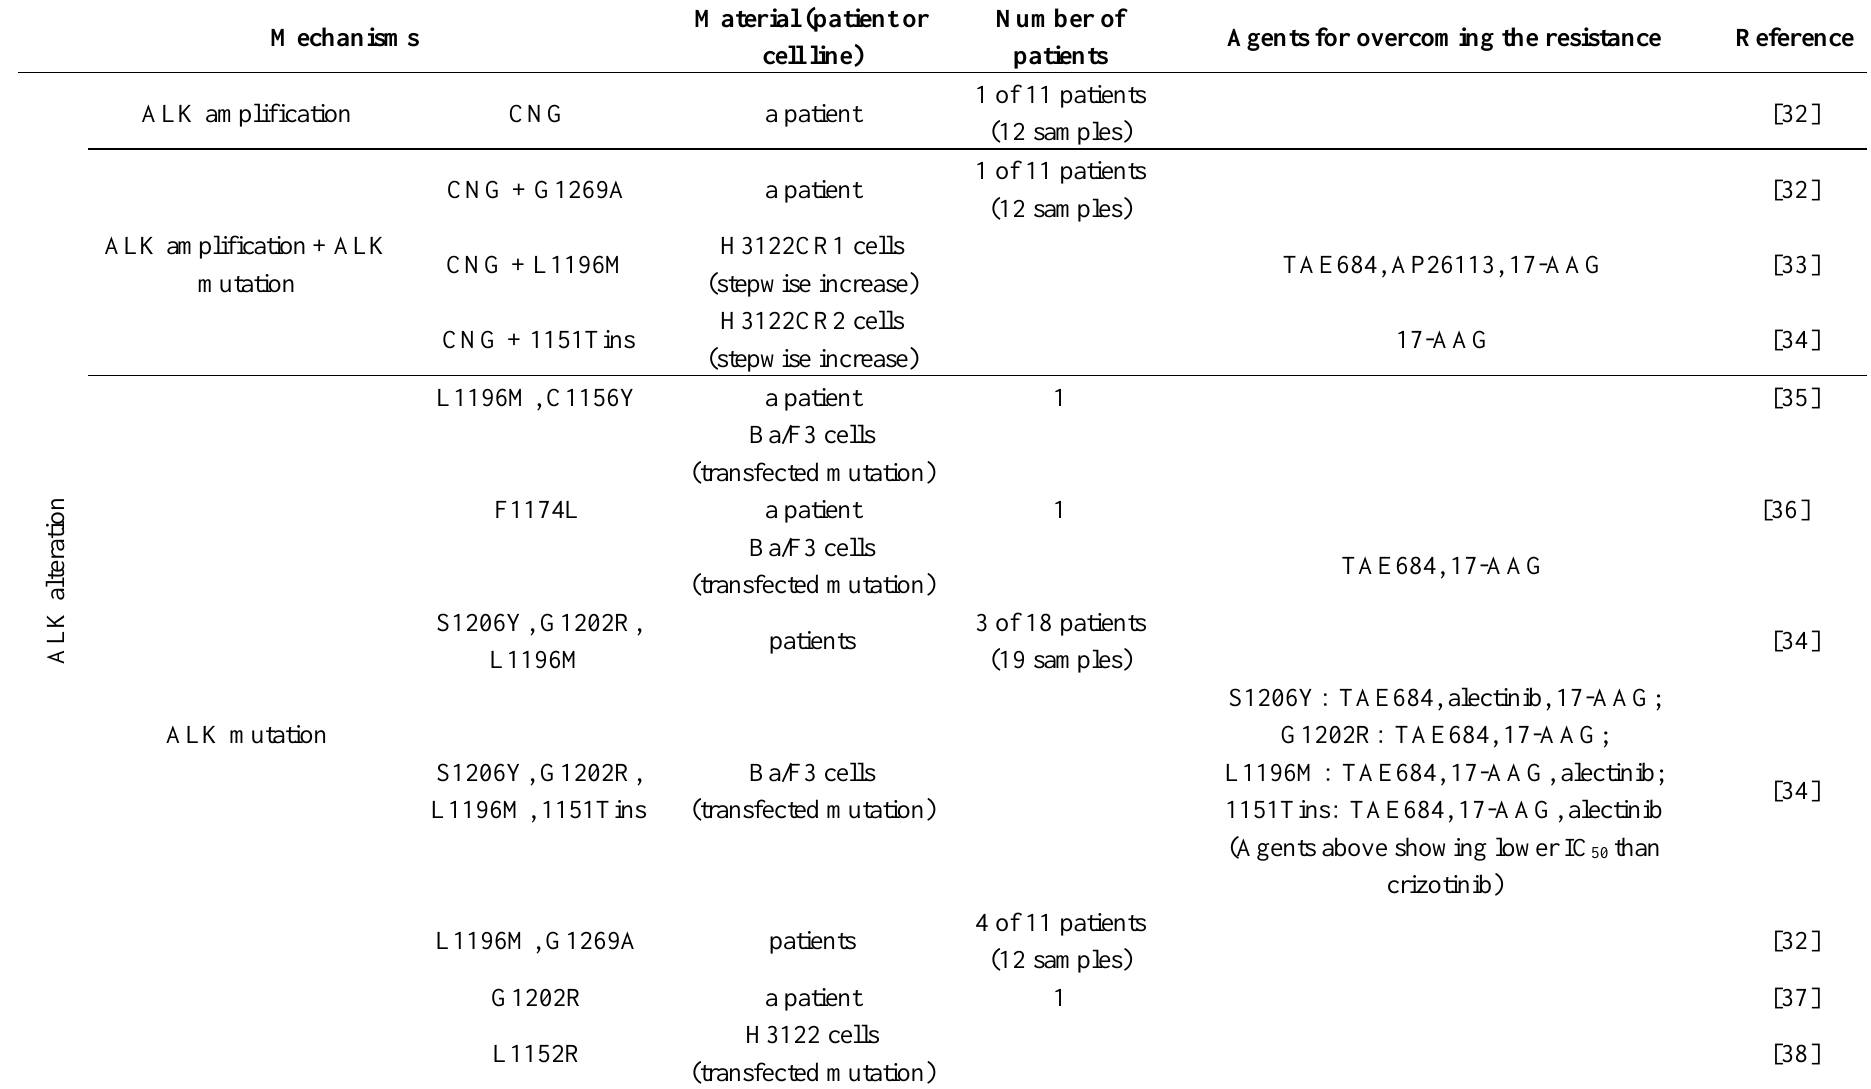
Table 2. Crizotinib resistance